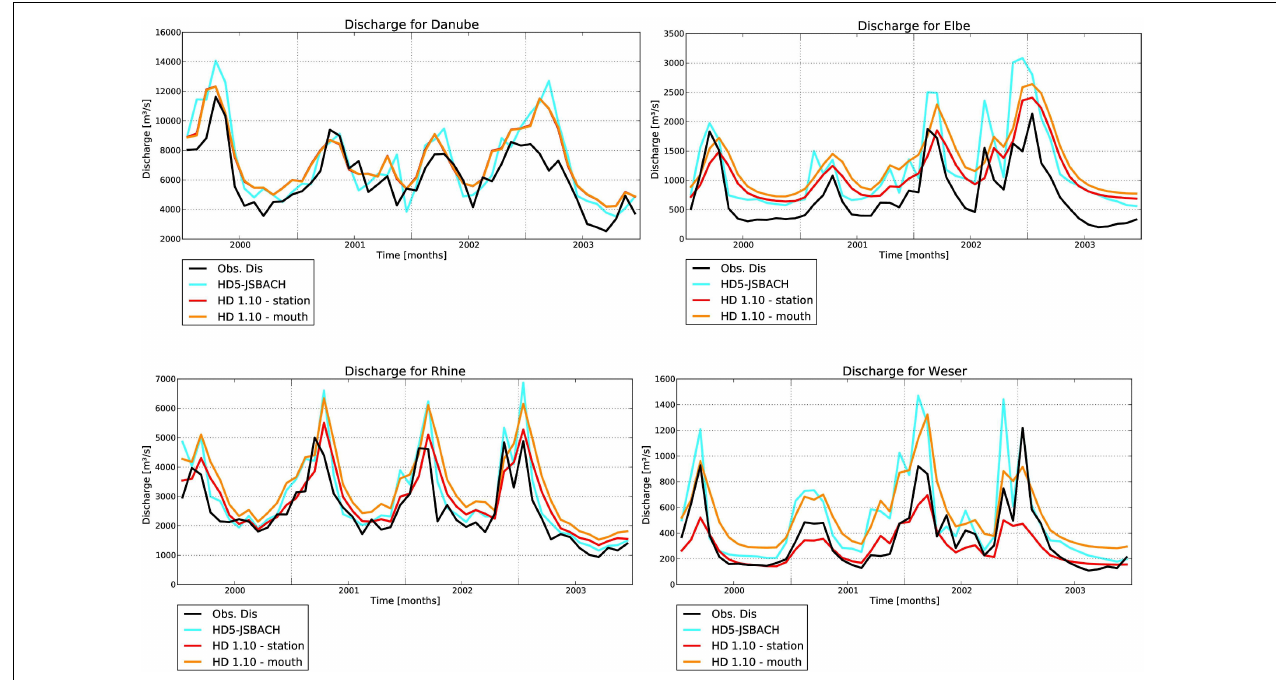
FIGURE 5 | Simulated and observed monthly discharges for selected rivers from 2000–2003. Simulated discharges comprise HD5-JSBACH and HD 1.10 simulations at 0.5 ◦ whereat for the latter, discharges close to the discharge gauge and the river mouth are provided. Note that for the Danube, the station is close to the river mouth so that the related discharges are almost identical.